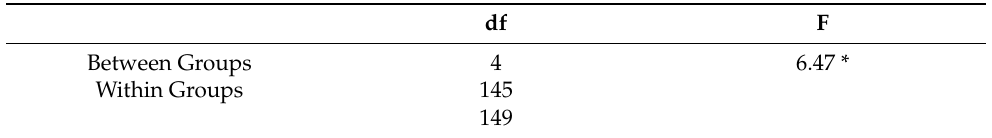
Table 2. Differences in the number of collisions that occurred during a rehabilitation process depend- ing on the sequence in which they were conducted.